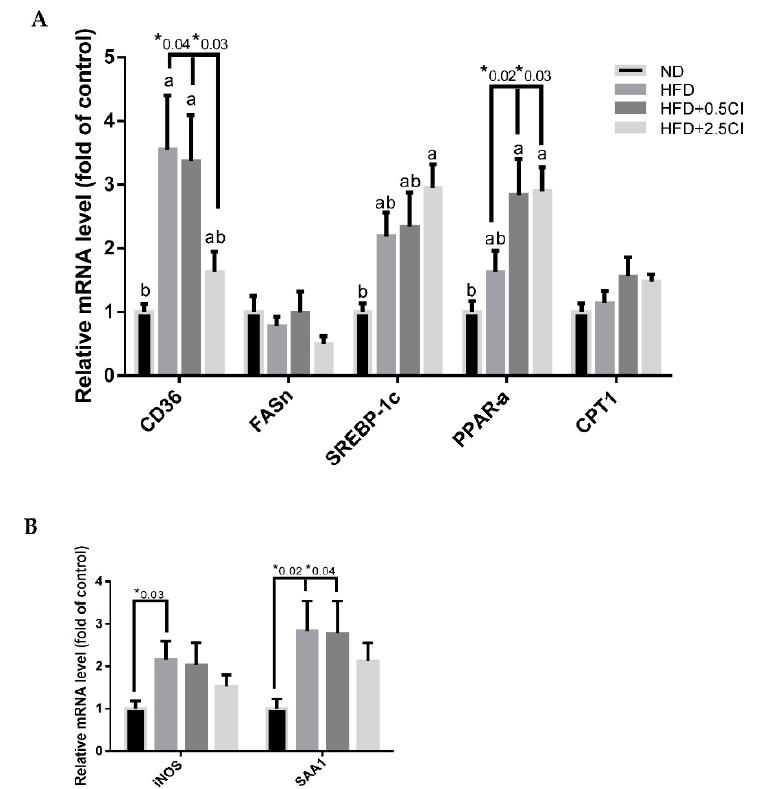
Figure 5. Effect of Chiliadenus iphionoides supplementation on genes related to liver carbohydrate and lipid metabolism. Male C57BL/6J mice were fed with normal diet (ND), high-fat diet (HFD), high-fat diet + 0.5 mg/kg Chiliadenus iphionoides (HFD + 0.5CI), high-fat diet + 2.5 mg/kg Chiliadenus iphionoides (HFD + 2.5CI) for fifteen weeks. ( A ) Gene expression of CD36, Fasn, SREBP-1c, PPAR- α , and CPT1 levels; ( B ) Gene expression of iNOS and SAA1 levels were measured. Values are expressed as mean ± SEM (ND, HFD, HFD + 0.5CI n = 10, HFD + 2.5CI n = 9). Different letters denote significant difference ( p < 0.05, Tukey’s HSD) asterisk denotes significant difference ( p < 0.05, Student’s t